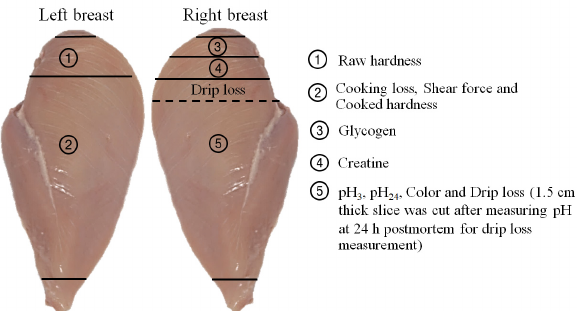
Figure 1. Pectoralis major muscle sampling location for the evaluation of glycogen content, creatine content, and meat quality .